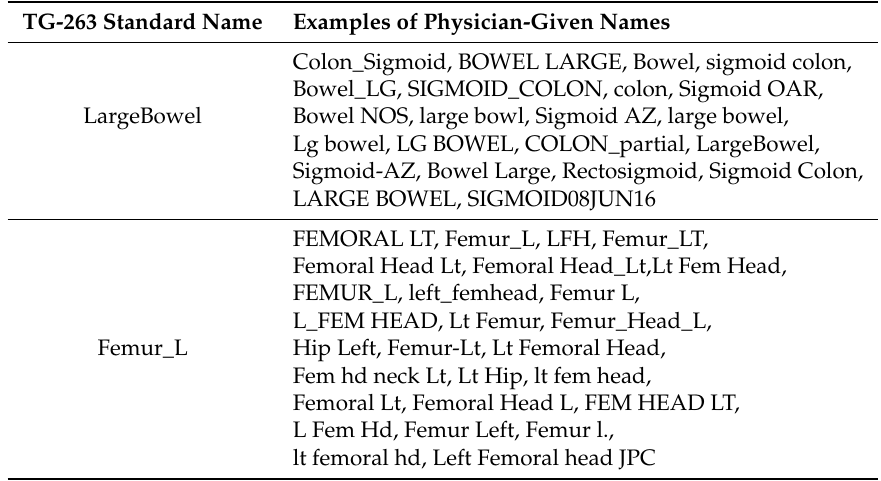
Table 3. Examples of physician-given names of structures from 40 VHA-ROQS centers. These are some examples from all the names given by